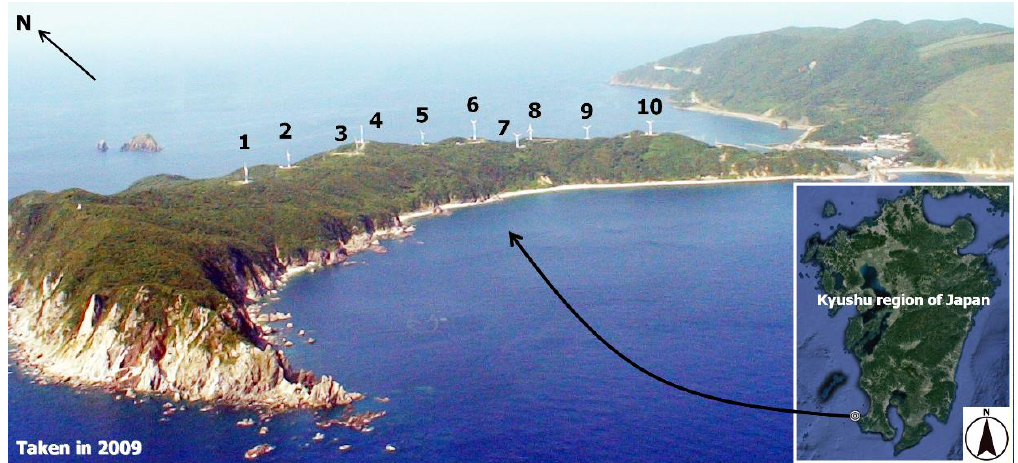
Figure 11. Complex terrain targeted in this study and ten wind turbines constructed at the Noma Wind Park.